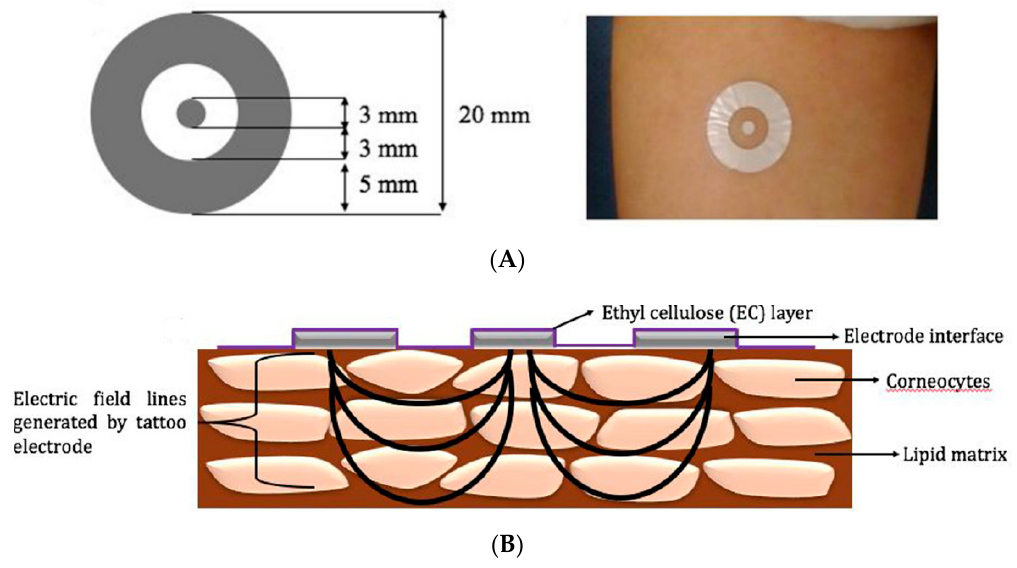
Figure 34. ( A ) Left: scheme and dimensions of the tattoo electrodes; Right: tattoo electrodes as applied on the inner forearm. ( B ) Side-profile scheme of the electrical field from the tattoo electrodes across the stratum corneum (SC). Reproduced from [98] with permission. © 2017 Wiley-VCH Verlag GmbH & Co. KGaA, Weinheim.